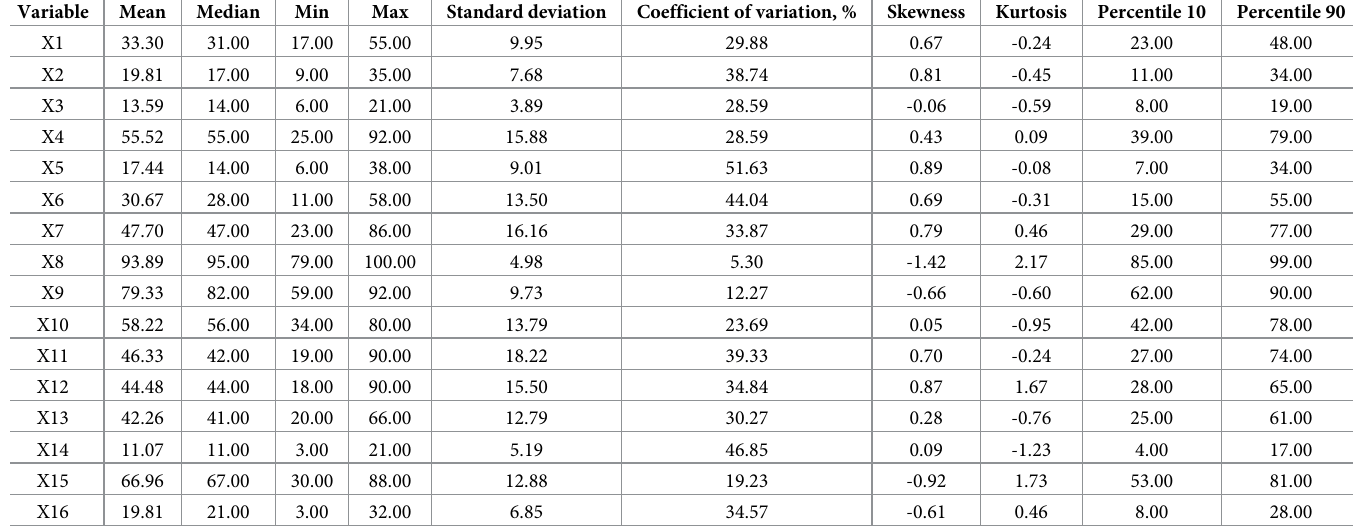
Table 5. Statistical parameters of indicators determining the level of the EU countries in terms of digitalization and robotization of large enterprises. Variable